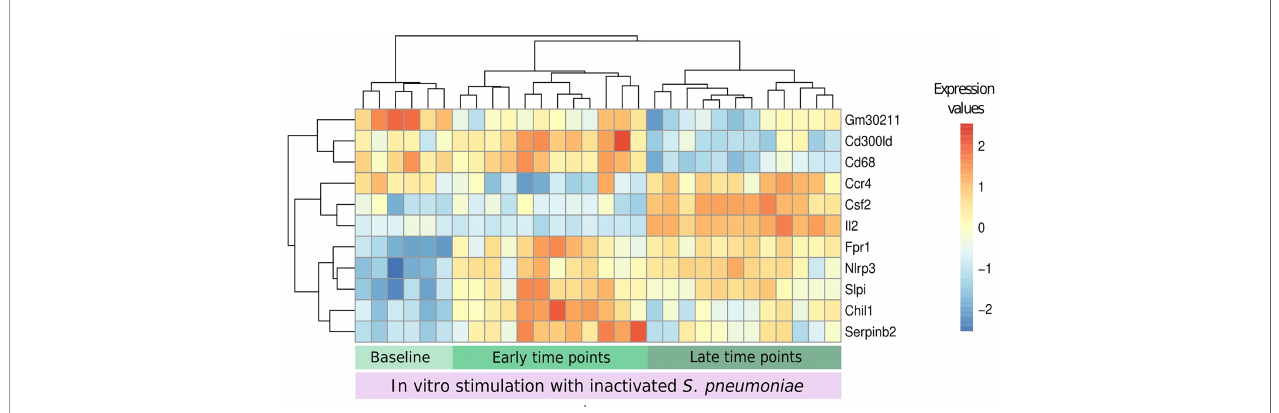
FIGURE 8 | Biomarkers of recall immune response. The DaMiR-seq package combines different classi fi cation methods to select possible biomarkers. After selecting the stimulated samples, this package was used to fi nd genes involved in the differences between infected and uninfected samples after stimulation. Groups were established based on the results of data distribution (IPCA and sIPCA) and cytokines, where we observed a shared pattern between early time points (days 1 and 2) and another pattern at late time points (4 and 7). Eleven genes were selected based on the drop of the feature importance ( Supplementary Image 1 ). The normalized expression values of the selected genes permitted to form three clear